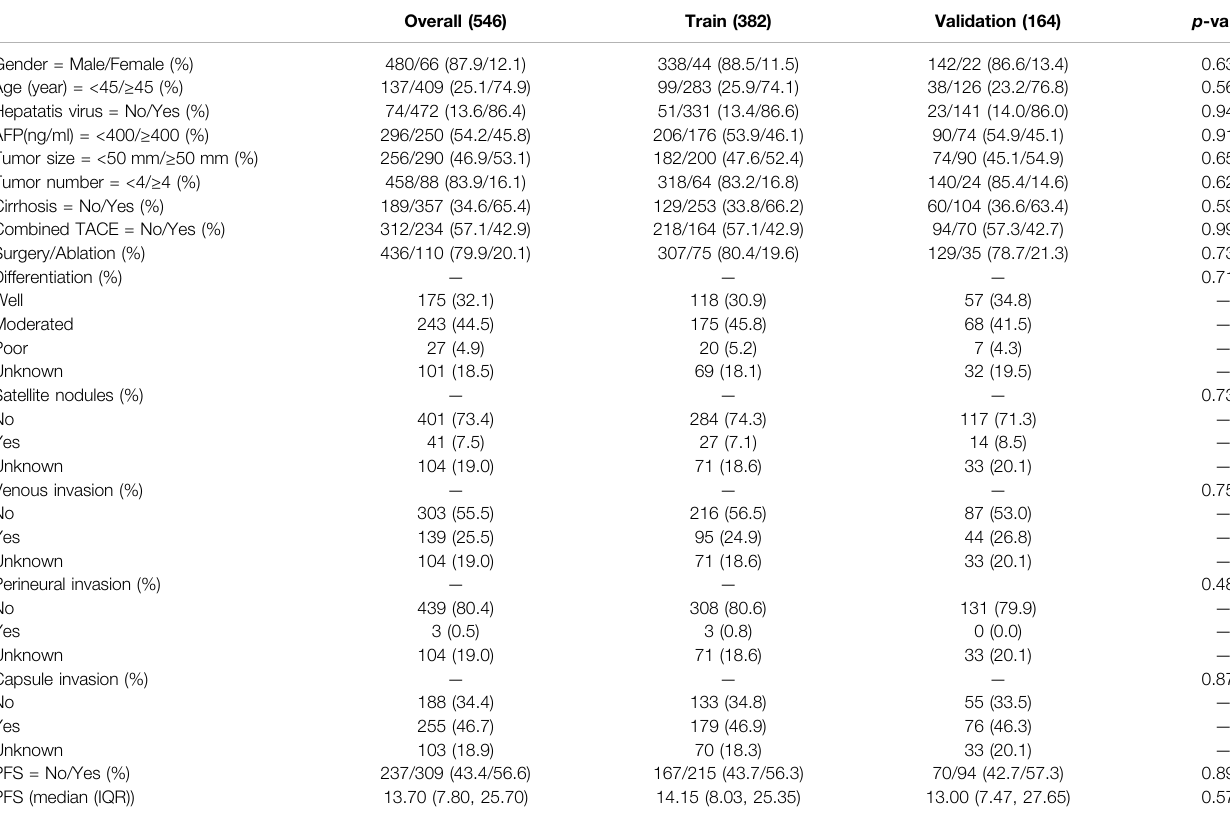
TABLE 1 | Patient characteristics in the train and validation cohorts.